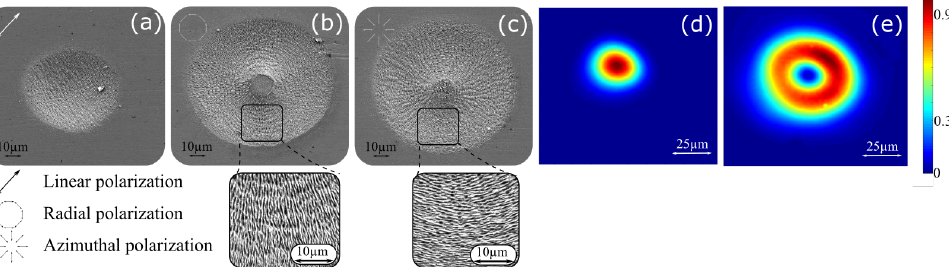
Figure 2. SEM micrographs of impacts on stainless-steel produced by linear Gaussian beam ( a ), azimuthal ( b ), and radial ( c ) polarized doughnut beams at arbitrary pulse energy. They are showing LIPSS perpendicular to polarization direction. Beam profile at focal plane of Gaussian beam ( d ) and doughnut profile with azimuthal and radial polarizations ( e